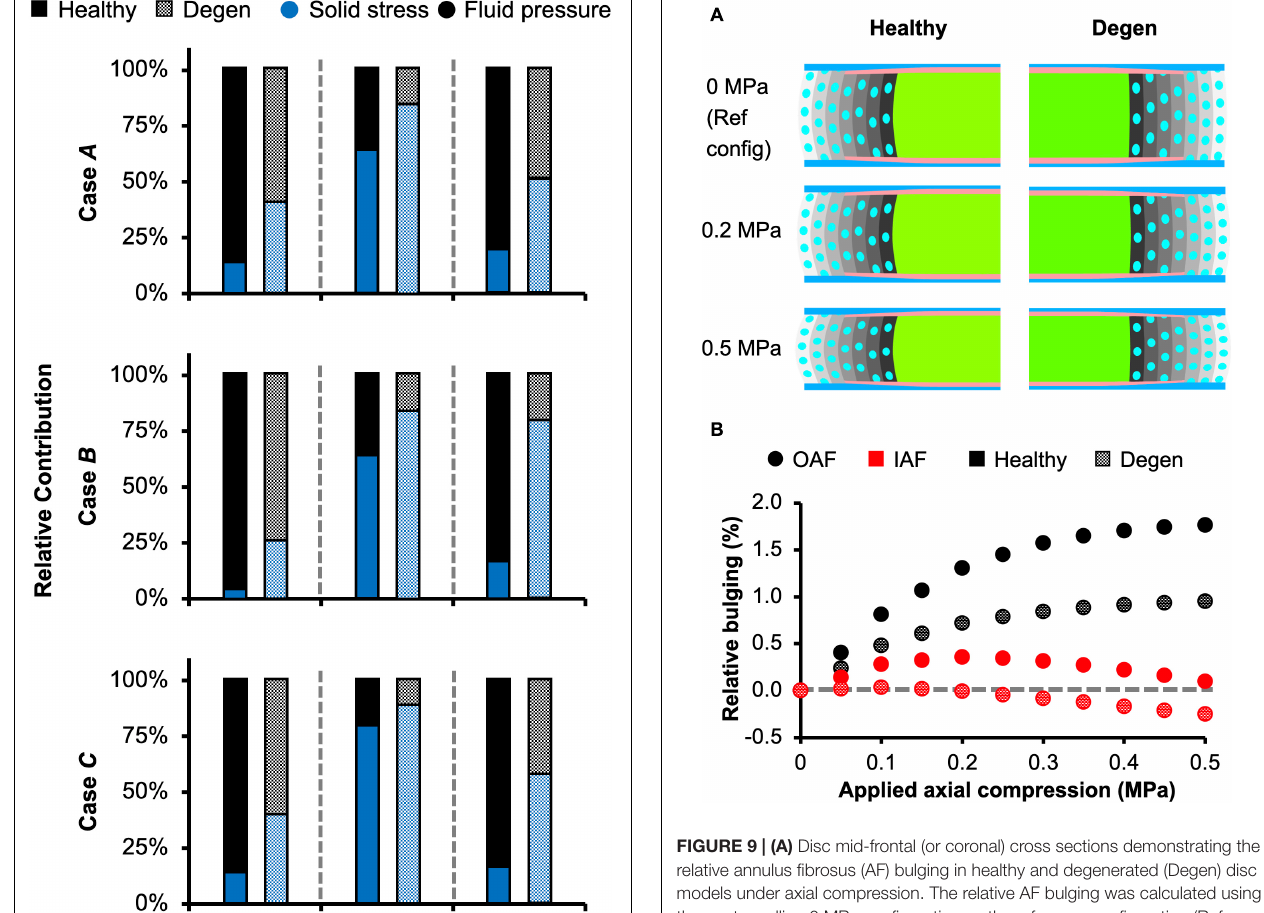
( Figure 11 –dashed vs. solid lines).